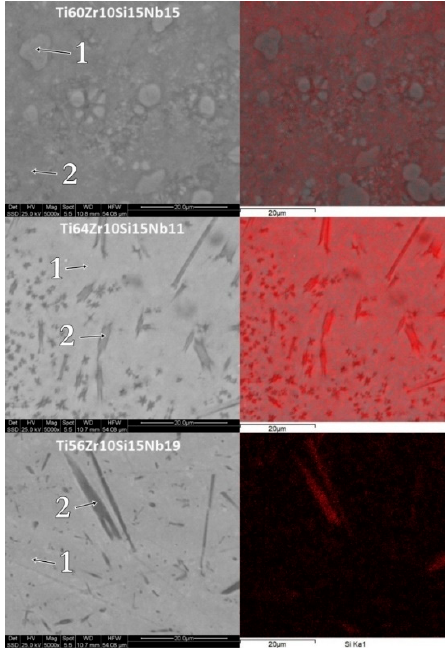
Figure 8. Surface morphology and chemical mapping (Si) for the melt spun alloys, obtained with 28 m/s peripheral speed.